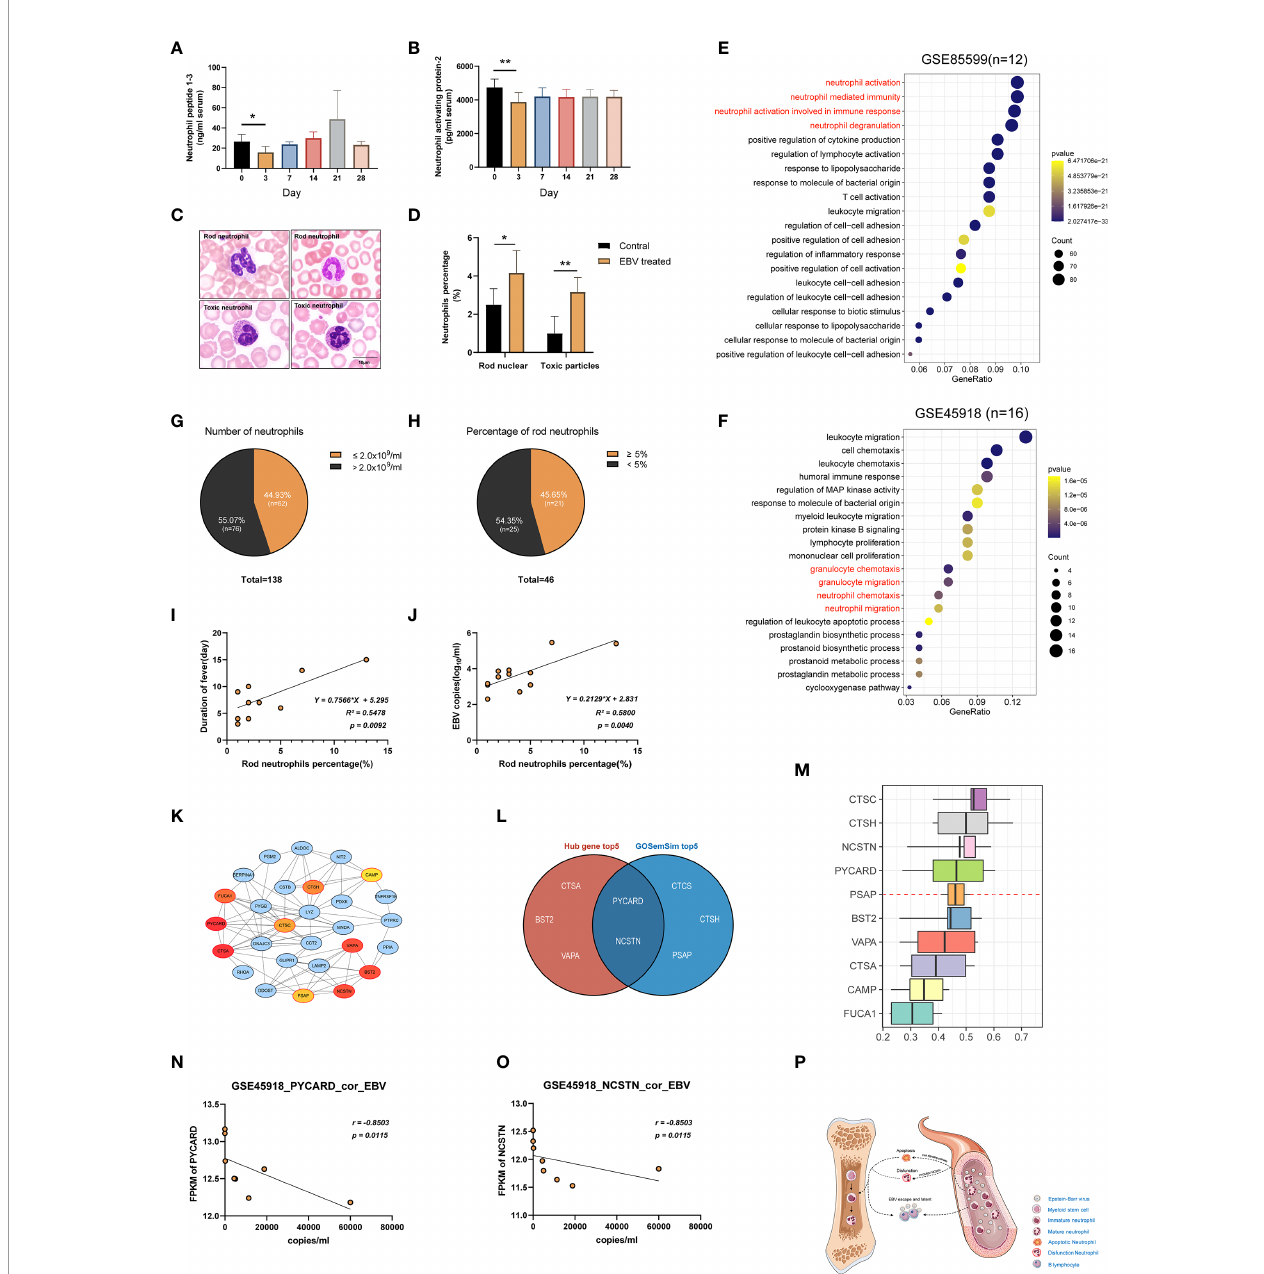
FIGURE 7 | Suppression of neutrophils after EBV infection. (A, B) ELISA examination of Neutrophil peptide 1-3 and Neutrophil activating protein-2 were examined. (C) Morphology of neutrophils with rod-shaped nucleus or speci fi c intoxication particles in the cytoplasm in the blood of tree shrews (Wright-Giemsa stain). (D) The ratio of neutrophils with a rod-shaped nucleus or speci fi c intoxication particles in peripheral blood smear. (E, F) GSE85599 and GSE45918 datasets of patients with infectious mononucleosis (IM) demonstrating the function of neutrophils was downregulated based on GO enrichment analysis of down-regulated genes in the datasets. (G, H) The proportion of patients with a reduced number of neutrophils and an increased percentage of rod-shaped nucleus neutrophils in the reviewed cases with IM. (I, J) A simple linear regression model between the percentage of rod-shaped nuclear neutrophils, days of fever, and EBV DNA copies of blood was generated to determine R 2 (coef fi cient of determination) and P-value (Signi fi cance of the correlation). (K) The PPI network of the neutrophil-related pathway in tree shrews at 3 dpi. Node color re fl ects its DMNC scores, such that a higher score of a node is denoted by a redder color of the node. The nodes with red borders represent the hub genes. (M) The weight value of the top 10 genes according to GO semantic similarity. The horizontal axis refers to the value of weight. (L) The Venn diagram showing the intersection of top5 genes of DMNC score and top5 genes of the weight value of GO semantic similarity. (N, O) Correlations of gene expression levels of PYCARD and NCSTN with EBV copy number in GSE45918 dataset. r-values represent the Spearman correlation coef fi cient. (P) Neutrophil suppression hypothesis. *p<0.05,